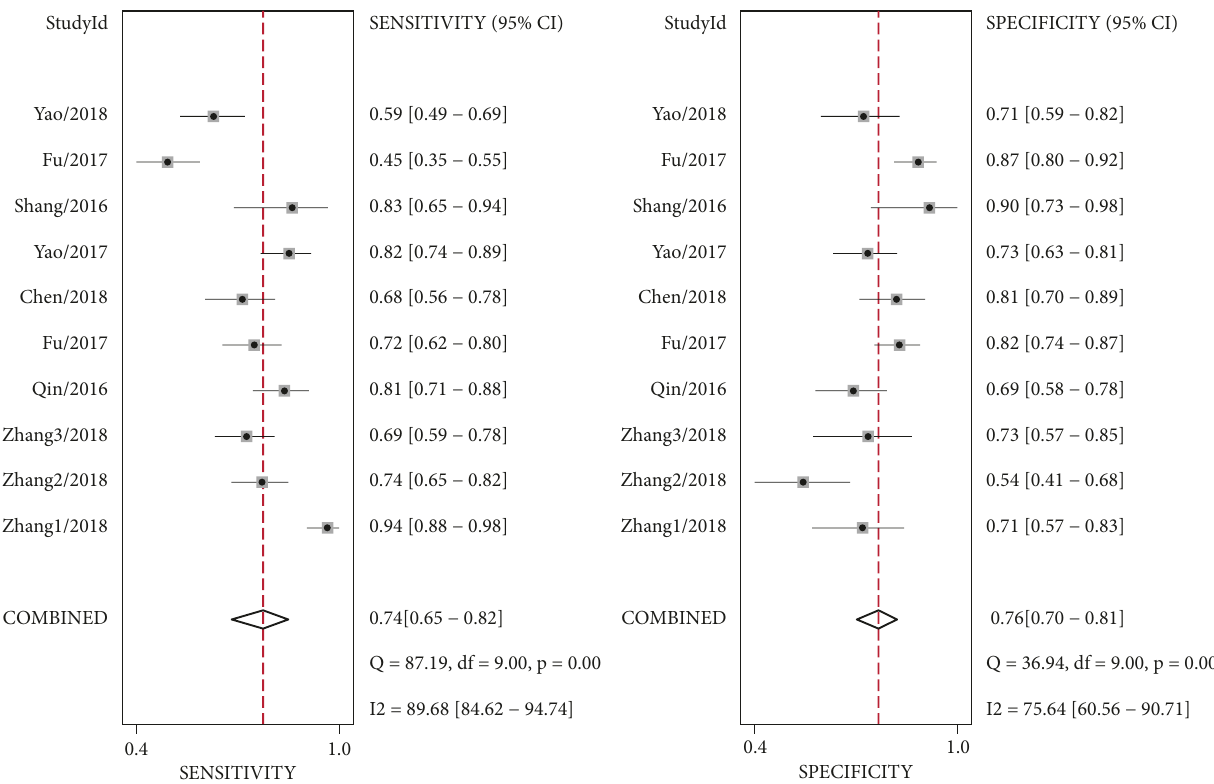
Figure 2: Forest plots of sensitivities and specificities of cirRNAs for the diagnosis of HCC.